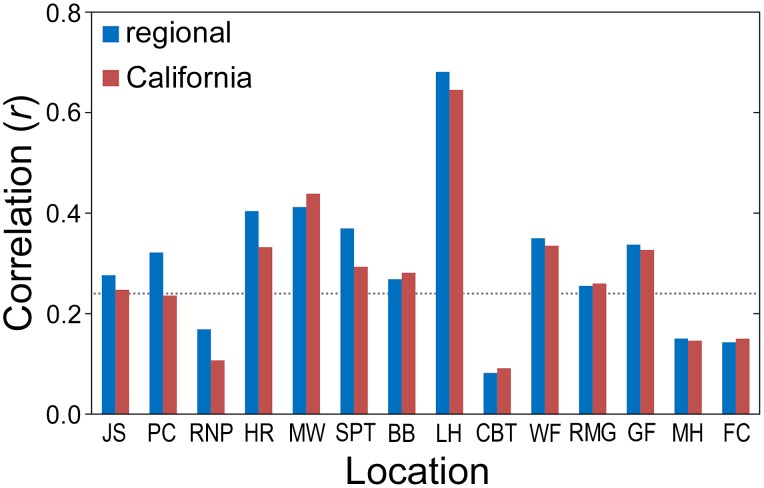
Summary of radial growth sensitivity to summer drought indices for two species at 14 locations.Correlations of residual Sequoia sempervirens and Sequoiadendron giganteum tree-ring chronologies against regional and state summer drought (average June–September PDSI) indices conducted over a 114-year common period (1895–2008). Dotted line represents cutoff for statistical significance (P<0.01). Locations arranged by latitude from north (left) to south (right) within species.